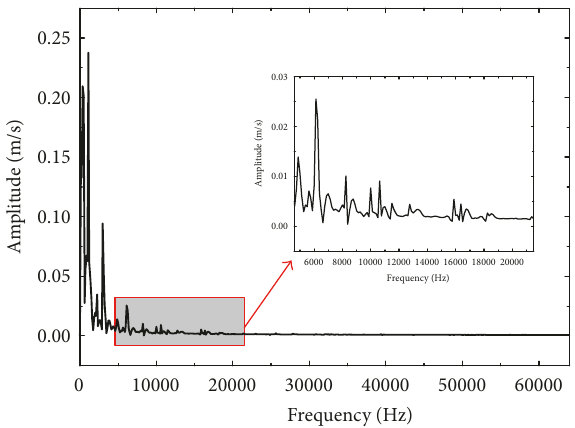
Figure 5: Amplitude-frequency curve of velocity of point